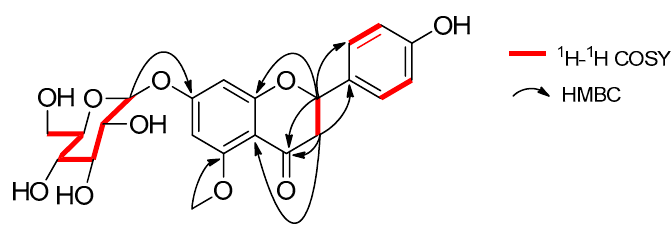
Figure 2. Selected 1 H- 1 H COSY and HMBC correlations of 1 .